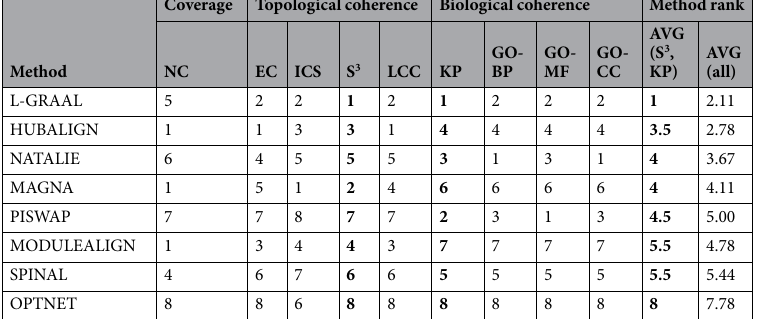
Table 1. Ranking network aligners. Network aligners (rows) are ranked according to the quality of their alignments: node coverage is measured with NC score (column 2), topological coherence is measured with EC, ICS, S 3 and LCC scores (column 3 to 6) and biological coherence is measured with KP, GO-MB, GO-MF and GO-CC scores (column 7 to 10). Aligners are sorted according to the average of their ranks, which is computed over S 3 and KP scores (column 11) and over all scores (last